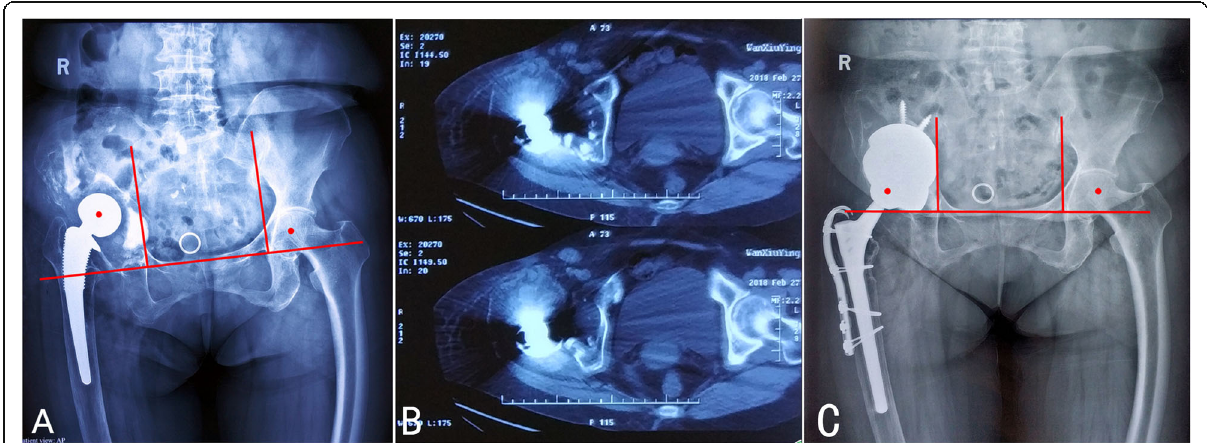
Fig. 3 A 66-year-old female patient who had an infected total hip arthroplasty. A The preoperative X-ray showing a Paprosky IIIB defect. B The pelvic continuity was confirmed on CT scans. C The “ hybrid cup ” reconstruction technique was used with 3 porous shells. The smaller middle cup was eccentrically cemented into the medial TM revision shell to fill the sideward defects. A larger porous cup was then impacted onto the “ cup- in-cup ” construct (out diameters of the shell from medial to lateral: 66 mm; 54 mm; and 62 mm)